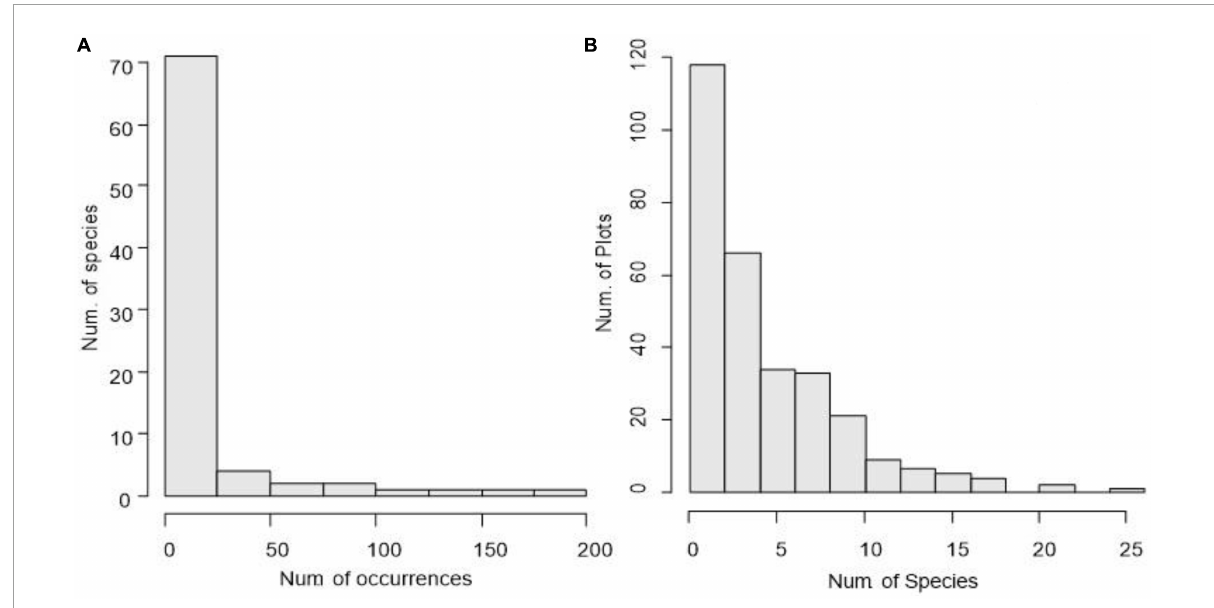
FIGURE1 Species occurrences (A) and species richness distribution of herbaceous plants (B) in Gutianshan subtropical